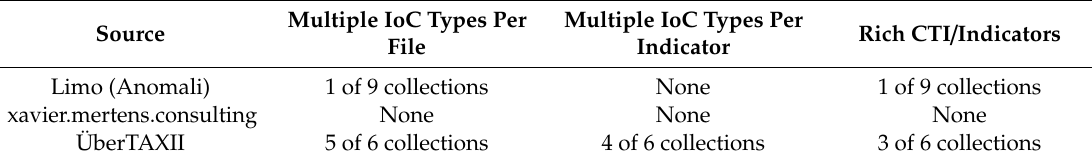
Table 5. STIX 2.x Feature